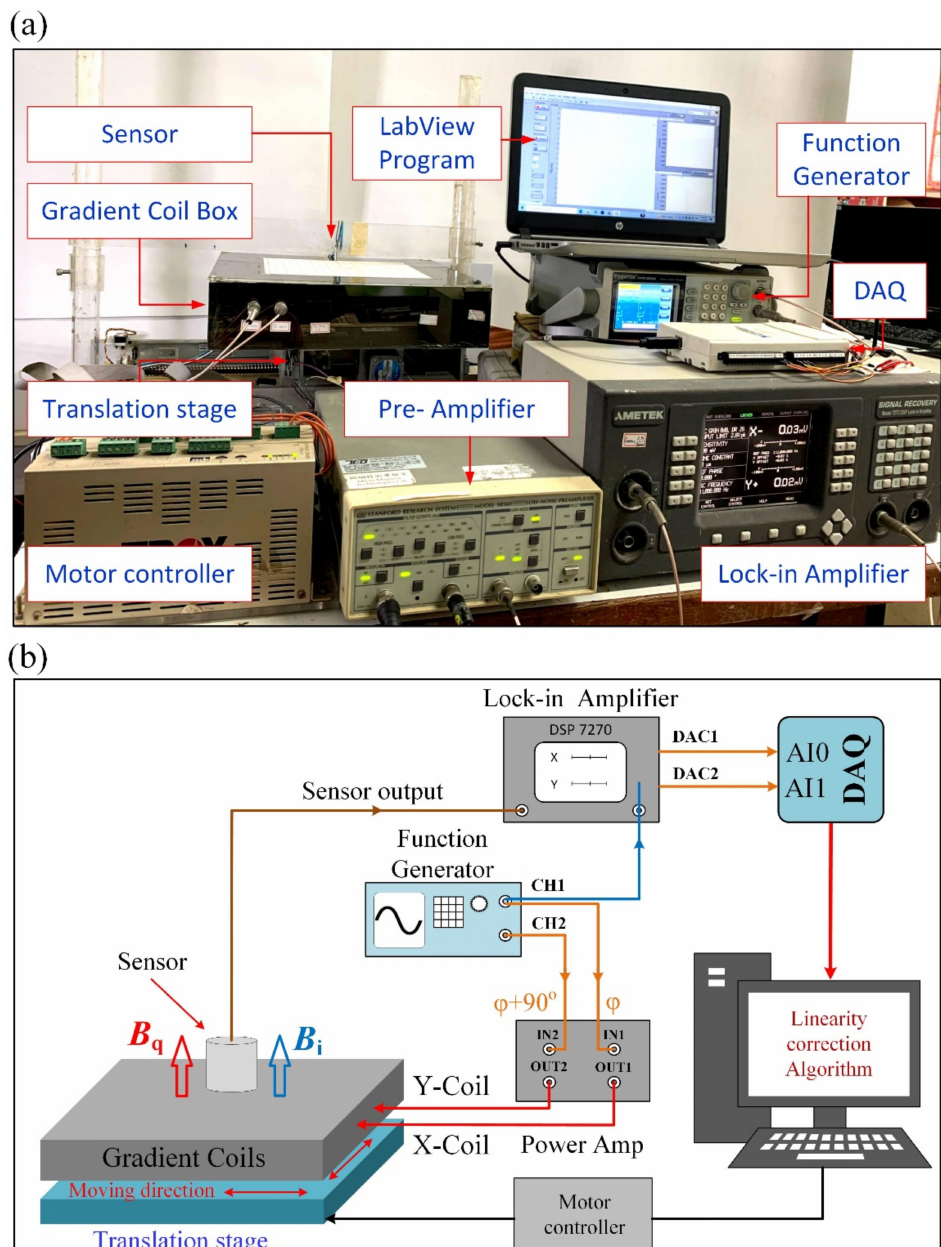
Figure 1. Schematic diagram of the 2D magnetic position tracking system. ( a ) Photograph of the system, and ( b ) Function block